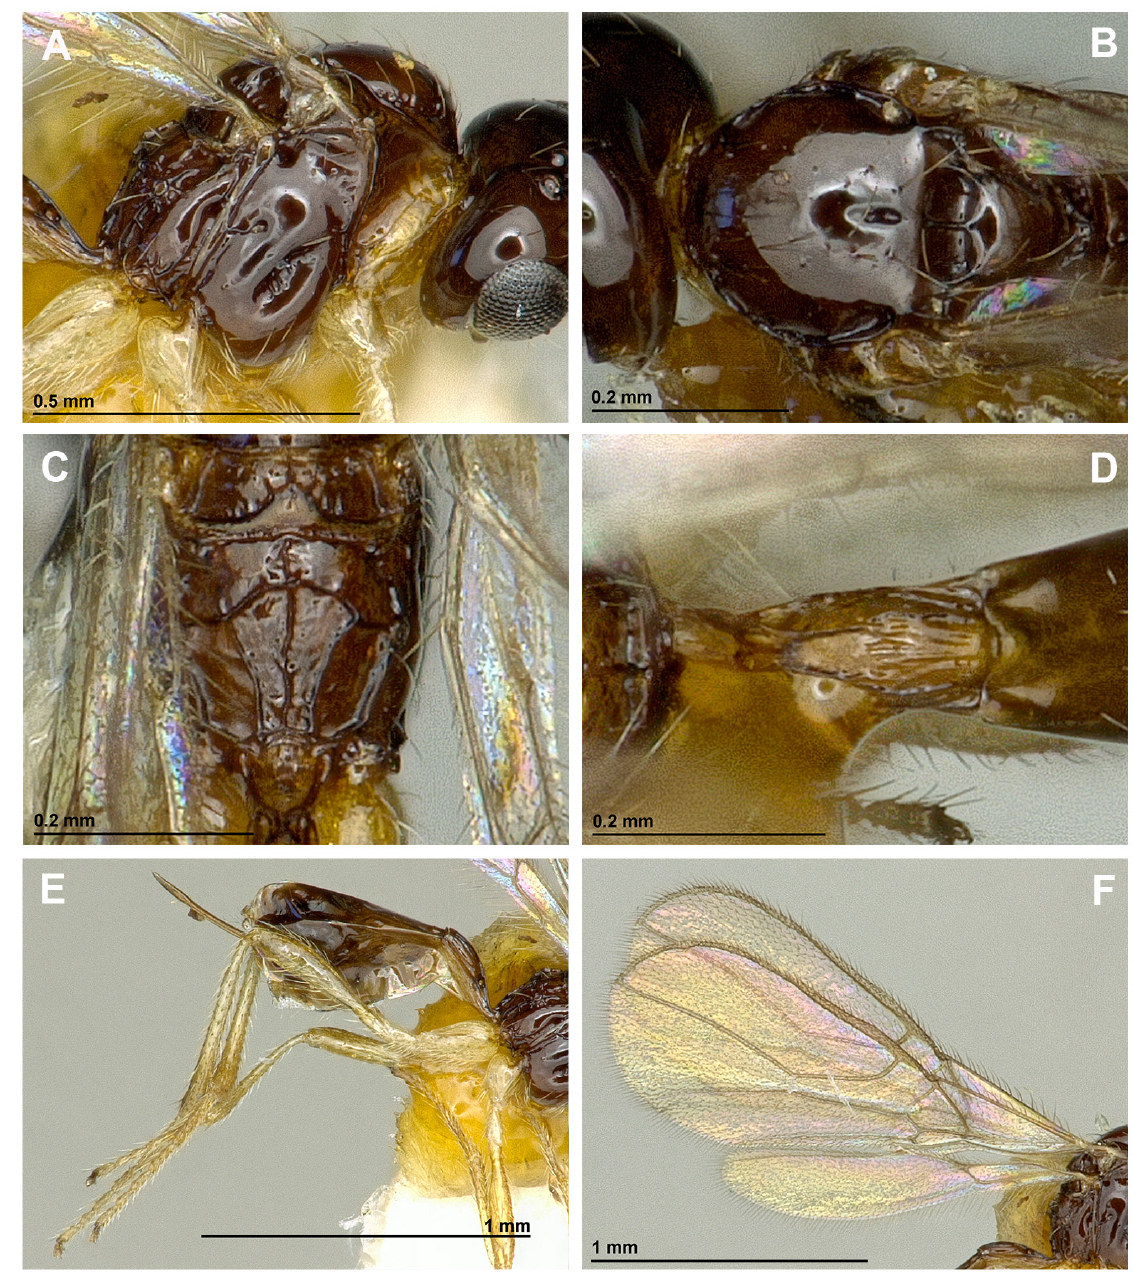
Fig. 3. Synaldis brasiliense Peris-Felipo, sp. nov., ♀. A . Mesosoma, lateral view. B . Mesonotum, dorsal view. C . Propodeum. D . First metasomal tergite. E . Legs, metasoma and ovipositor, lateral view. F . Fore and hind